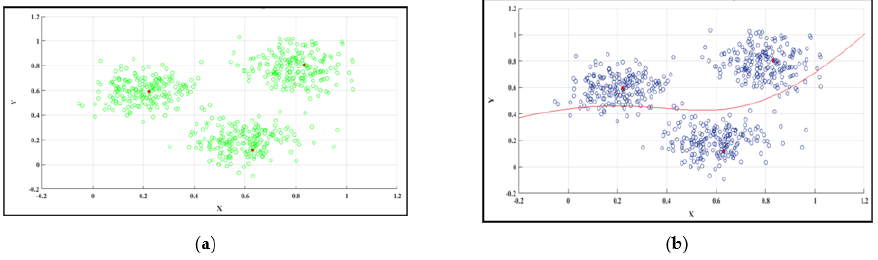
Figure 3. Divided the data set based on a collaborative filtering technique. ( a ) Three different groups based on collaborative filtering, ( b ) Determine a threshold value to select the group.